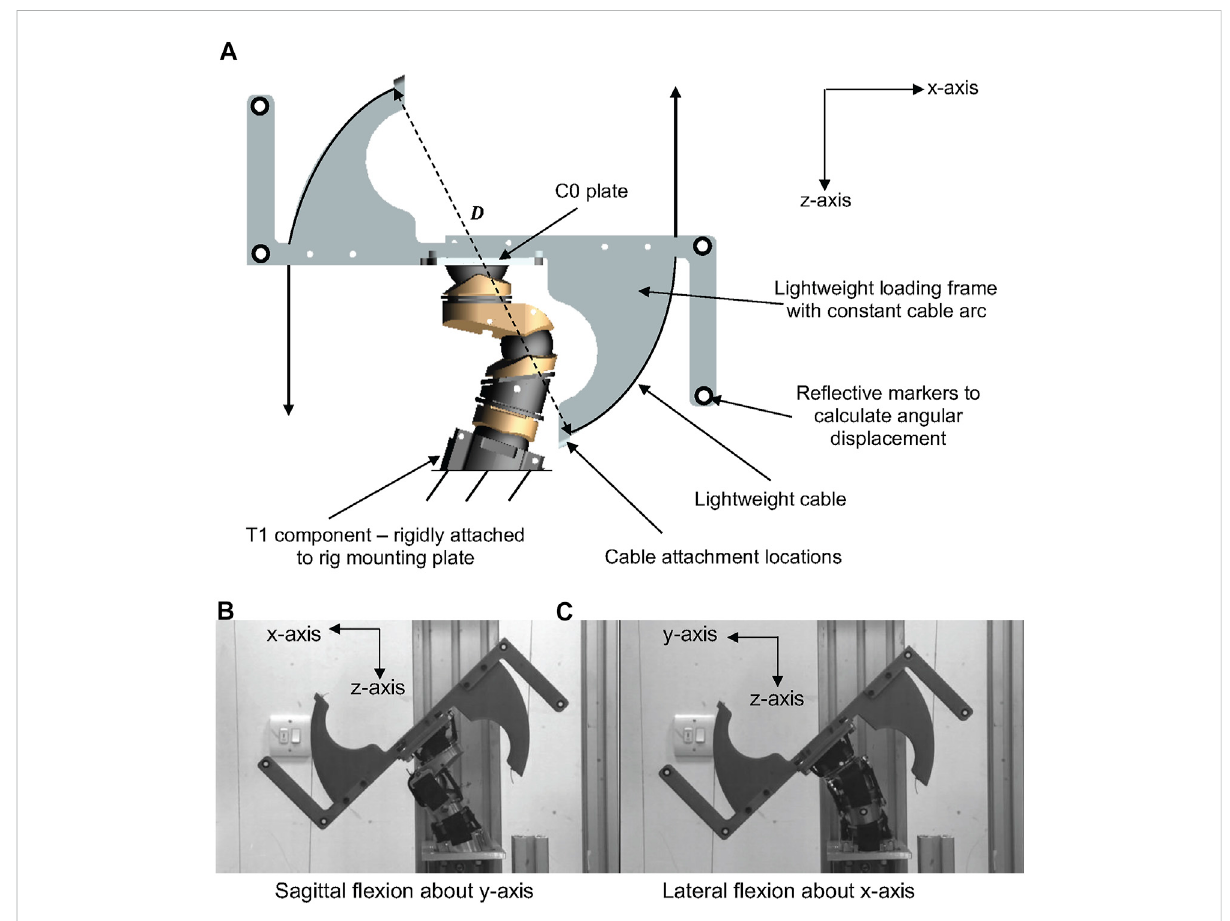
FIGURE 6 (A) SchematicrepresentationoftheLUSNintheneckbendingrig. (B) ExemplarloadingimageoftheLUSNinsagittal fl exionaboutthe y -axis. (C) Exemplar loading image of the LUSN in lateral fl exion about the x